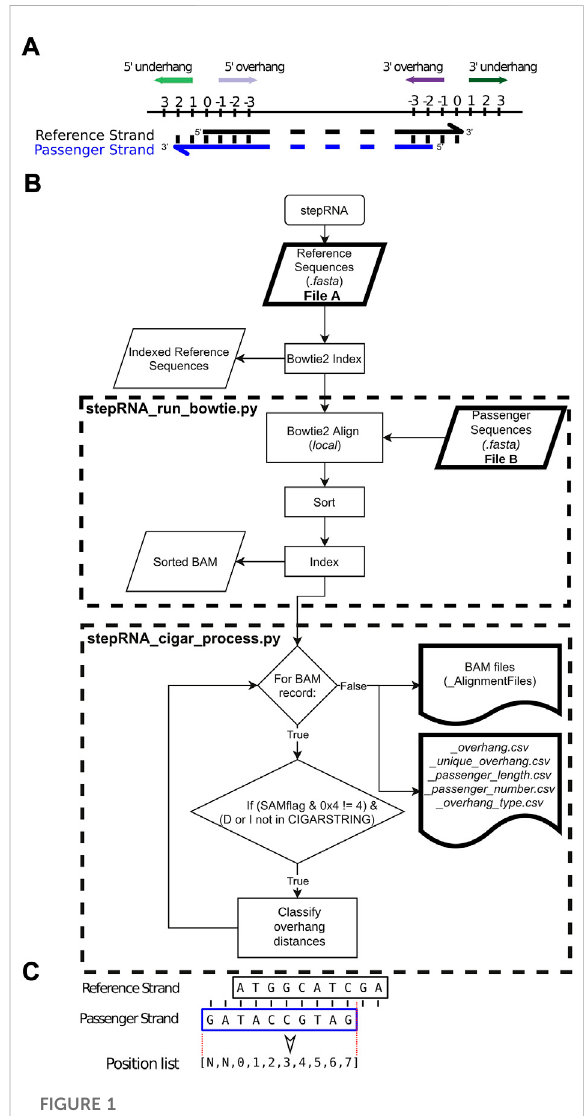
FIGURE 1 Overview of the stepRNA pipeline. (A) Diagram showing how stepRNA classi fi es a reference strand e.g. the guide RNA (black) and a passenger strand (blue) in a RNA duplex. A reference overhang (purple arrows) is represented by a negative score. A reference underhang (green arrows) is represented by a positive score. A blunt end is represented by a score of 0. In this example the reference strand has a 3 ′ overhang of 2 nt and a 5 ′ underhang of 2 nt. (B) Flowchart for the stepRNA pipeline showing an overview of the key steps. Modules that can be run independently are in dashed boxes. (C) Example of a siRNA duplex and the 0- based coordinate list, created by PYSAM, that stepRNA uses to classify the overhang distances for each siRNA duplex. The reference strand and passenger strand are represented by black and blue boxes, respectively. The dotted red line shows the region that is extracted, with softclipped bases in the passenger strand being represented as None